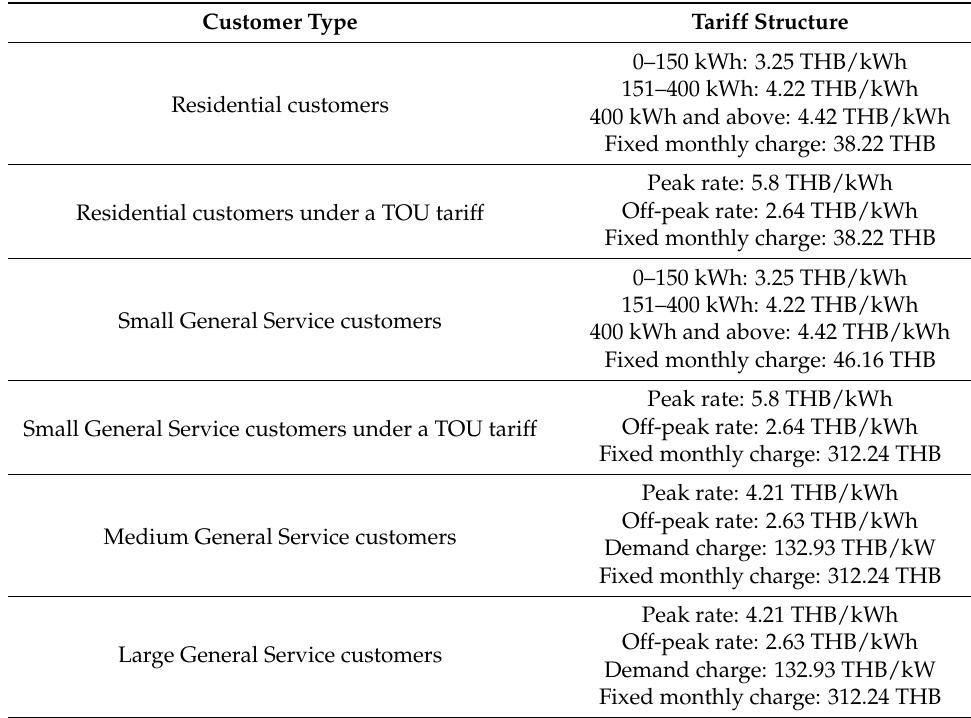
Table A2. Tariff structure for different customer